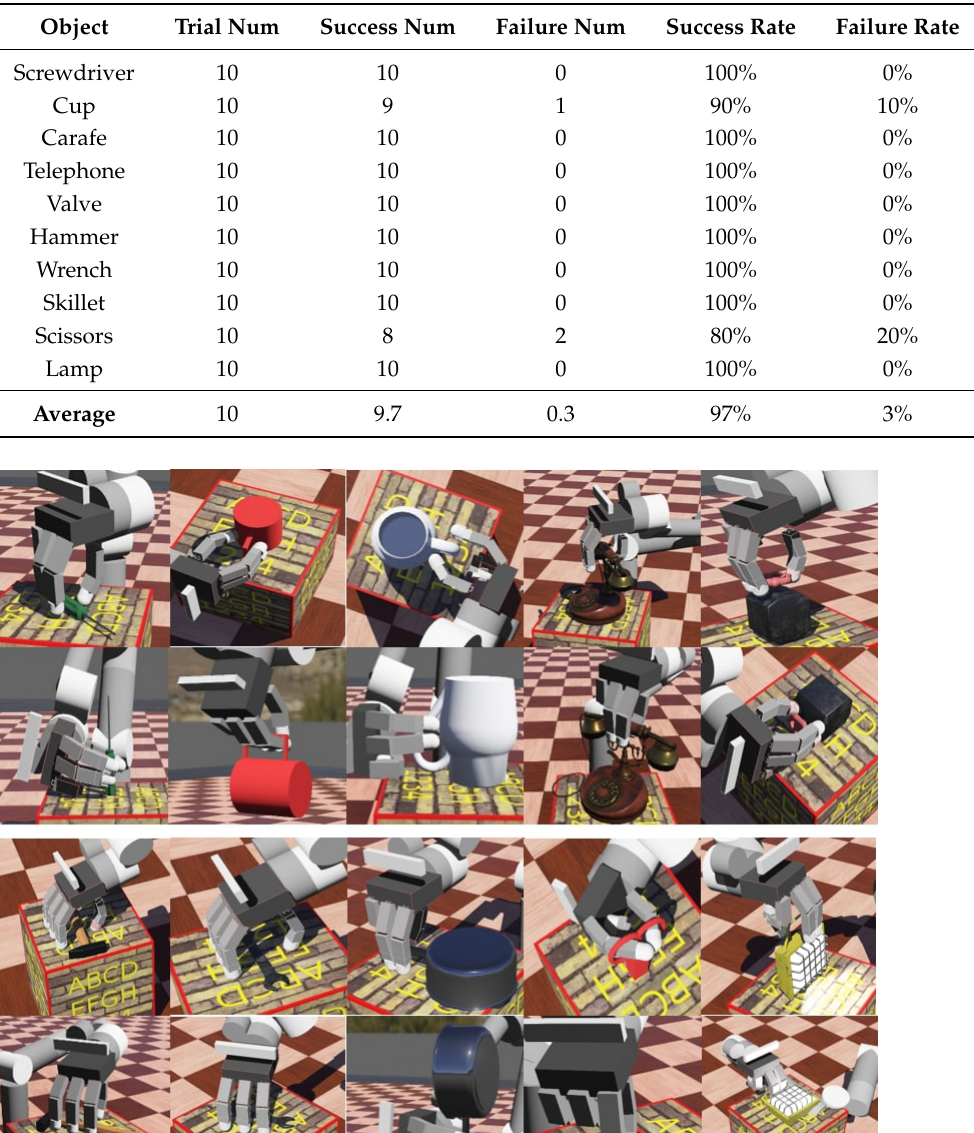
Figure 15. Ten objects used in simulation experiment. Table 1. Simulation results.